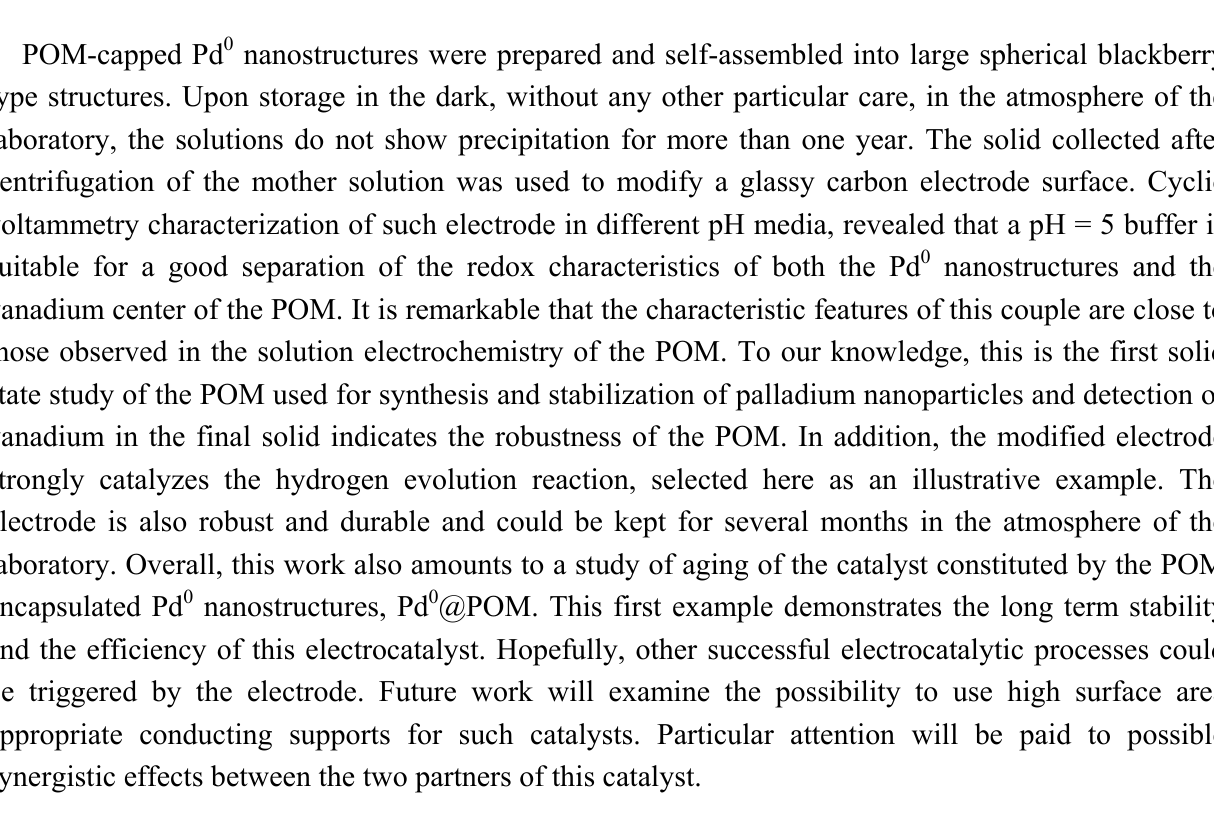
SO (pH = 0.30) with a Pd 0 @POM 2 4